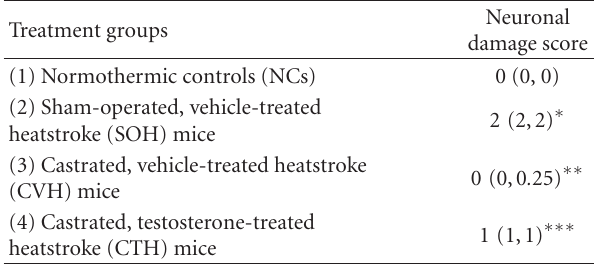
Table 2: Mean ( ± SEM) number of TUNEL-positive cells per tissue section for di ff erent groups of mice.